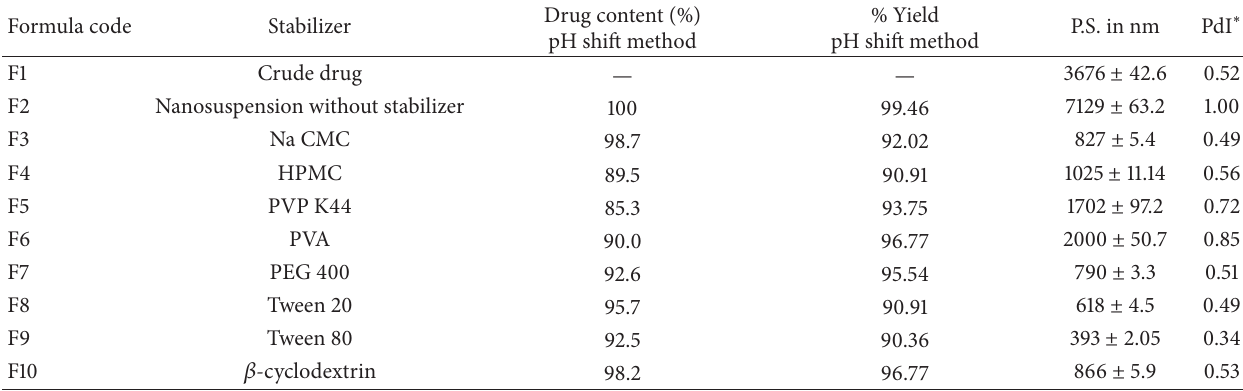
Table 1: Drug content, percentage yield, particle Size (P.S.), and size distribution of nanosuspensions prepared by pH shift method.